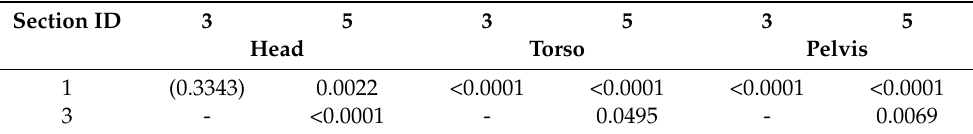
Table 2. p -value test for pairwise comparisons at the prominent peak frequency of the LVM group at the head, torso, and pelvis relative to the vehicle floor.